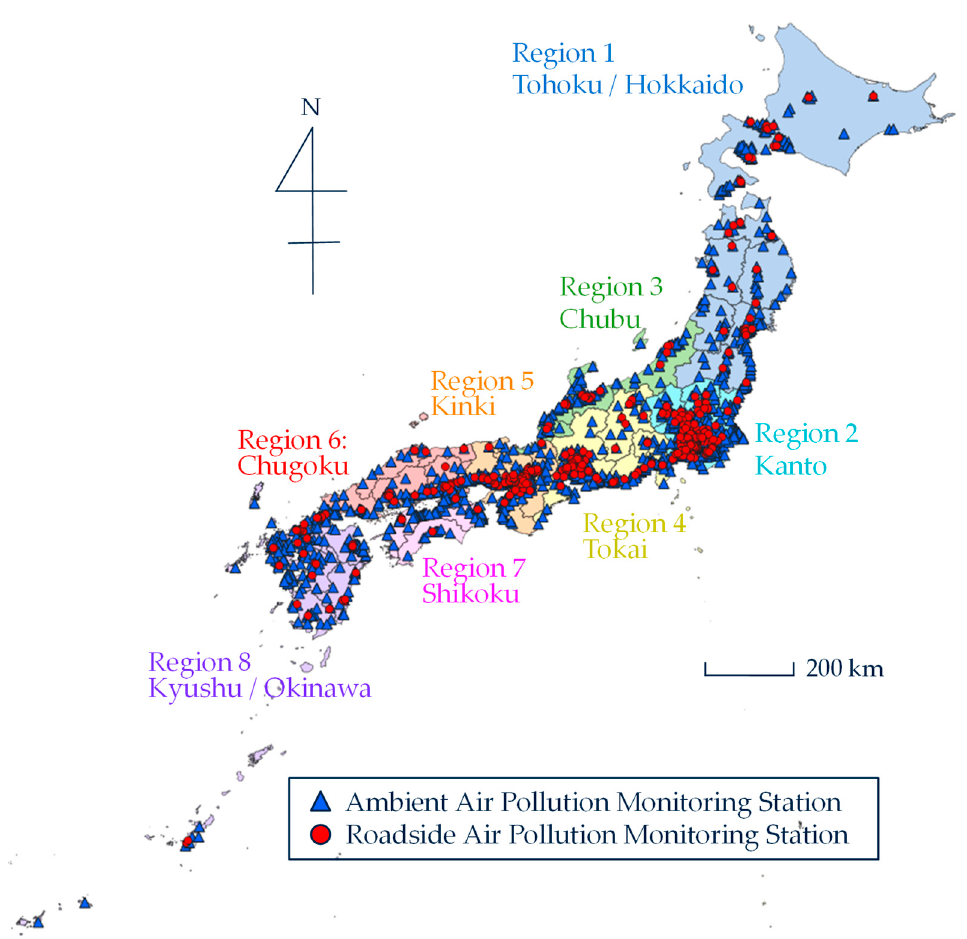
Figure 1. Distribution of ambient air quality monitoring stations (AAQMS) and roadside air quality monitoring stations (RsAQMS) in Japan and the eight regions (region 1 to 8) defined in this study.